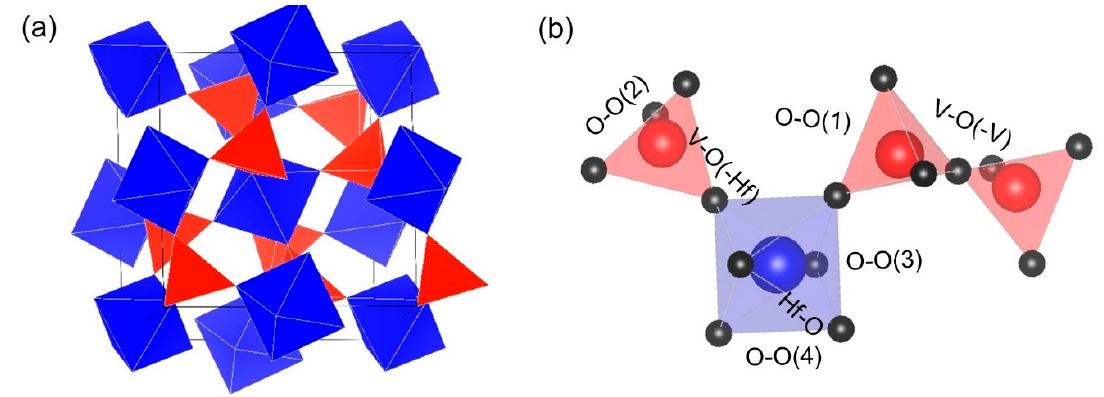
Figure 2. ( a ) Structure of the HfV 2 O 7 high-temperature phase, containing the HfO 6 octahedra (blue) and VO 4 tetrahedra (red). ( b ) Section of interconnected polyhedra with examples of individual bonds formed within the structure.